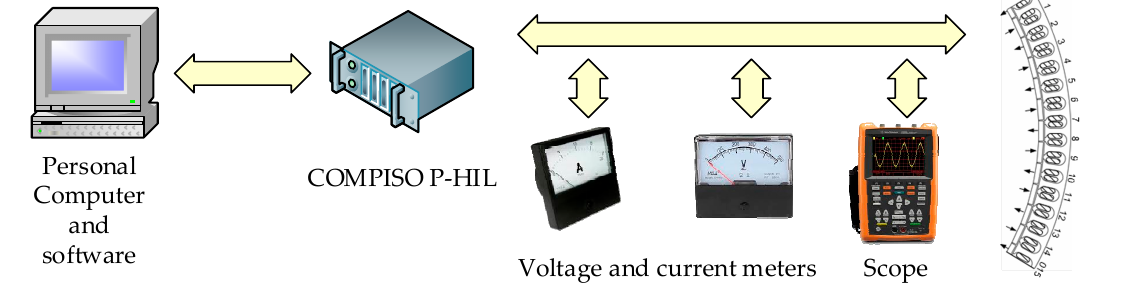
Figure 9. Functional diagram of experimental setup.